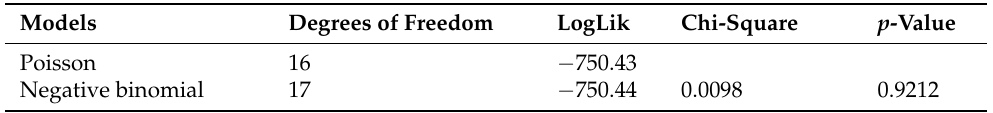
Table 2. Likelihood Ratio Test for Poisson and negative binomial models regarding COVID-19 notifications to the Municipal Health Department of Uberl â ndia